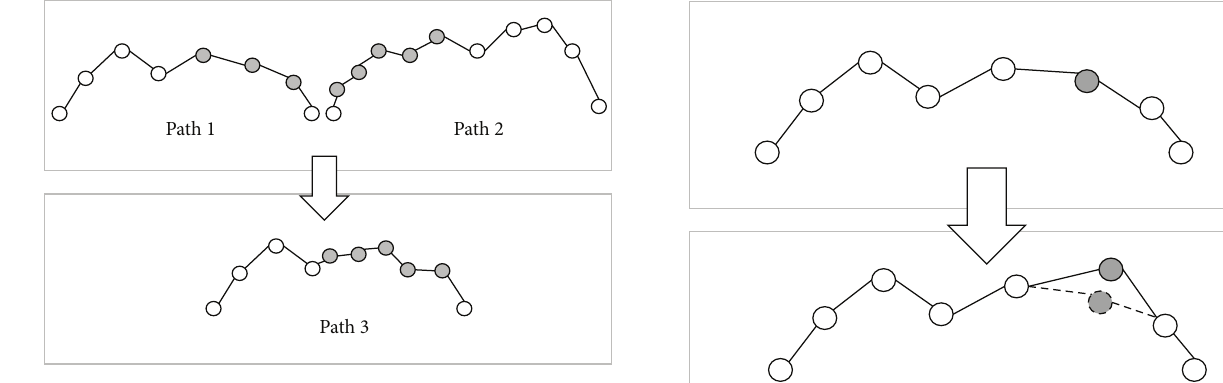
Figure 11: The corresponding paths of Figure 10.